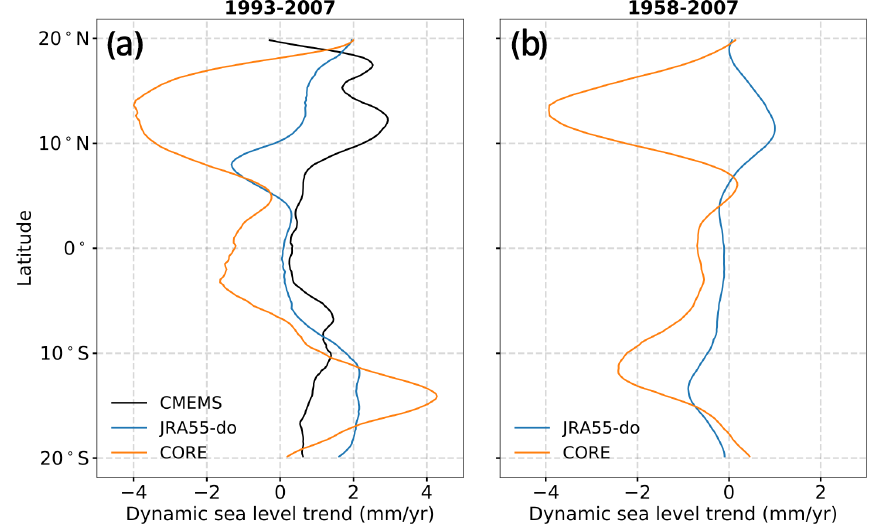
Figure 10. The zonal mean DSL trend from observations and the JRA55-do and CORE simulations during (a) 1993–2007 and simulations during (b) 1958–2007 over the tropical Pacific